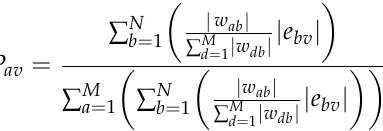
Table 4. Results from variable importance analysis in the ANN